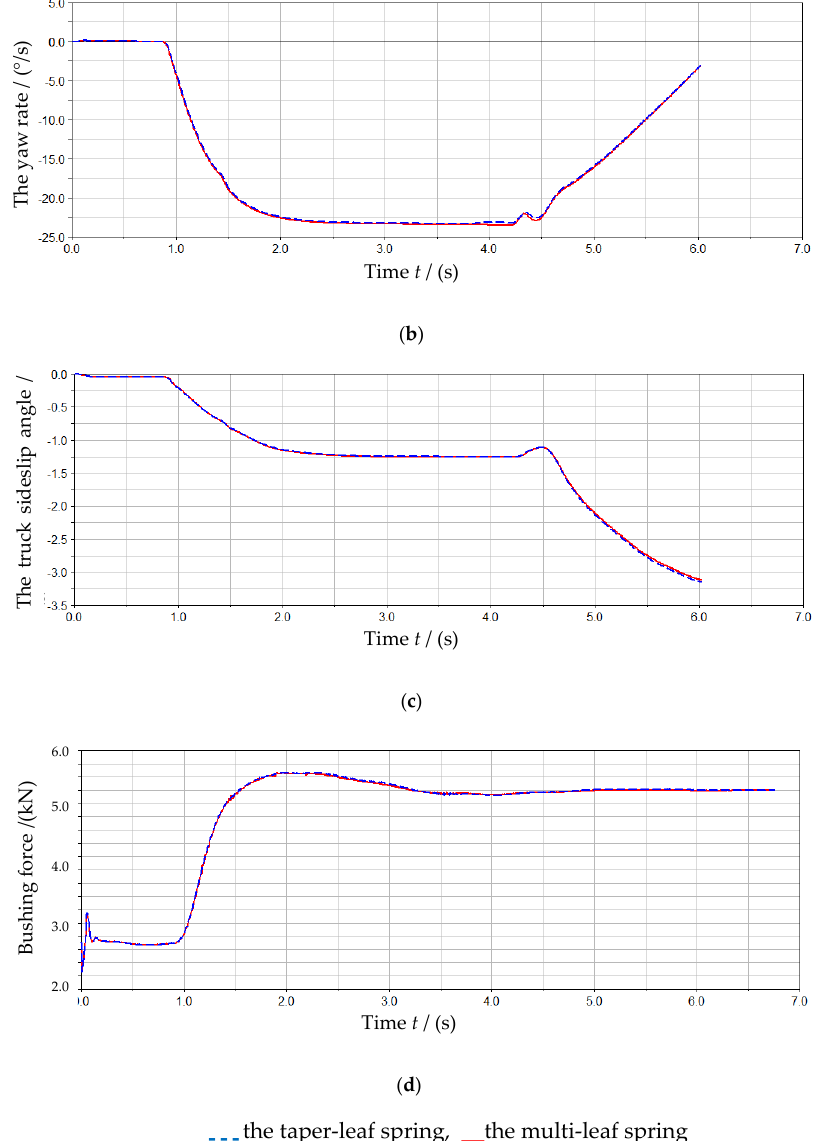
Figure 16. A comparison of the simulated dynamic responses obtained from the step steer tests: ( a ) The steering wheel torque, ( b ) the yaw rate, ( c ) the truck sideslip angle, and ( d ) the bushing longitudinal force at the spring eye.